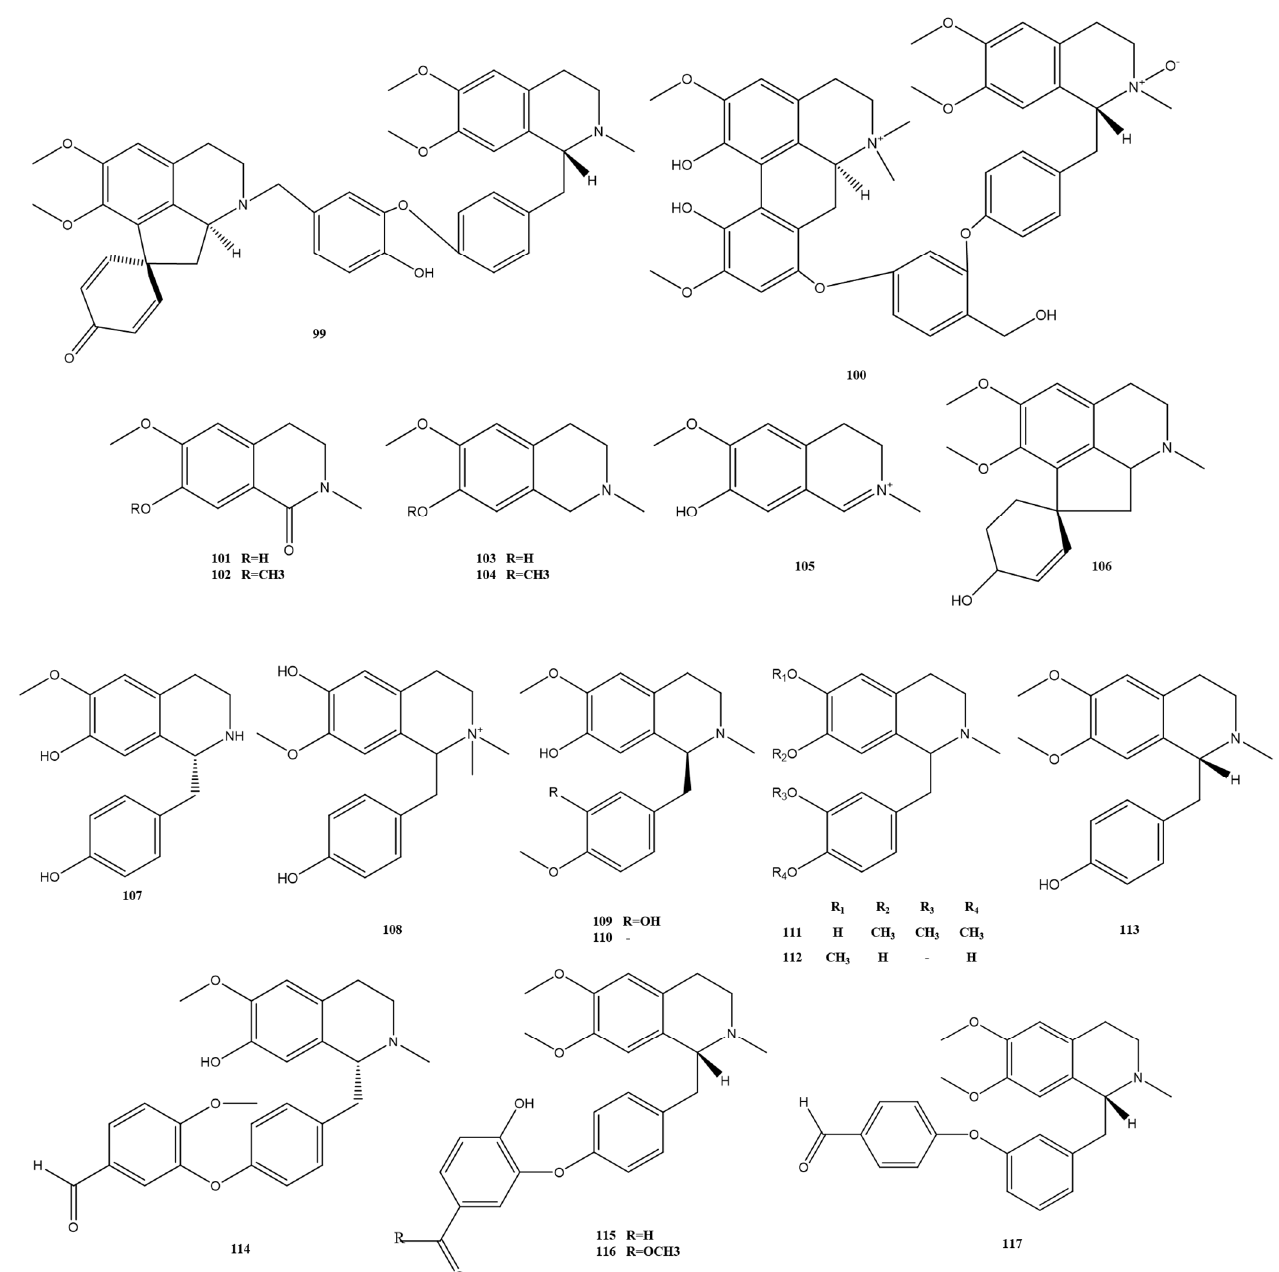
Figure 9. Apomorphine–benzylisoquinoline alkaloids (99–100), simple isoquinoline alkaloids (101 - 106), and monobenzylisoquinoline alkaloids (107–117) in M.